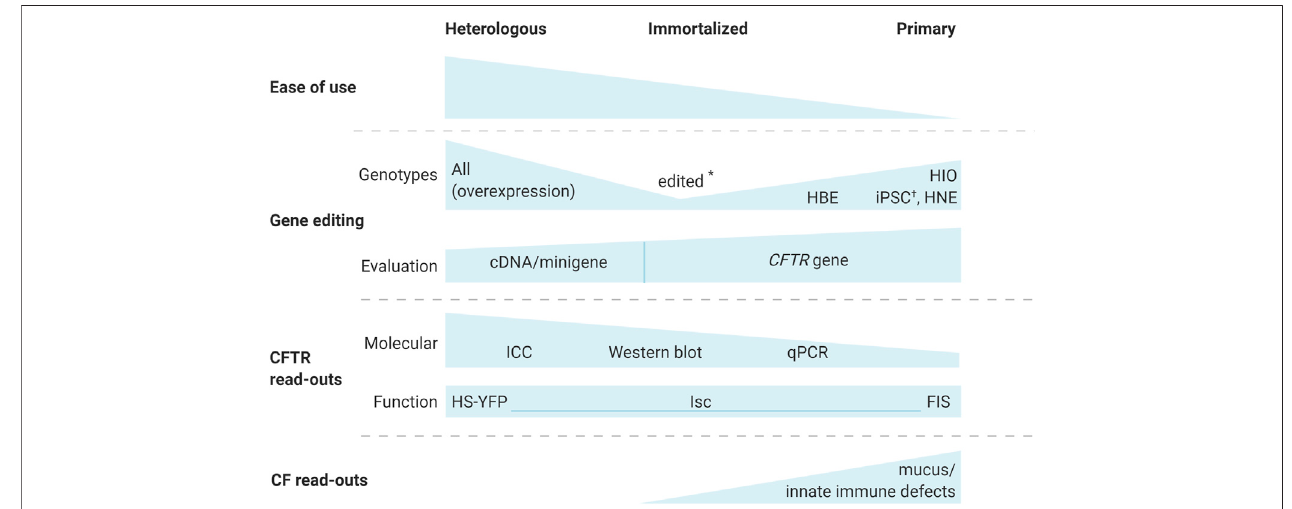
FIGURE 1 | Cystic fi brosis cell models for the evaluation of gene editing strategies. Different cell-based models are available to evaluate gene editing for CF. While heterologous, CFTR overexpressing models allow the study of any CFTR variant, and are easiest to work with, their read-outs are limited to molecular and functional analysisofCFTRandgeneticcorrectionatthecDNAorminigenelevel.Immortalizedcells,expressingtheendogenousCFTR,allowcorrectionofthe CFTR gene,butare only available for a limited number of the more common CFTR genotypes. Gene editing however, has allowed to generate immortalized lines for additional genotypes (*) (Valley et al., 2019). Primary cell models are the most relevant, since they can be used for CF speci fi c read-outs that are important in the CF phenotype, includingmucusandimmunedefects.TraditionalmolecularCFTRendpointsremainchallengingforprimarycells.Dependingontheoriginoftheprimarycells,genotypes mightbeexceedinglyhardtoacquirei.e.,humanbronchialepithelial(HBE)cellsfromexplantlungs.Ontheotherhand,humanintestinalorganoids(HIO)andhumannasal epithelial (HNE) cells are more readily obtained via minimally invasive procedures. Alternatively, iPSCs were edited ( † ) to generate isogenic lines with different genotypes (Ruan et al., 2019). A combination of different models allows the most complete cell-based evaluation of novel gene editing strategies. Abbreviations: FIS, forskolin induced swelling; HBE, human bronchial epithelial; HIO, human intestinal organoids; HNE, human nasal epithelial; ICC, immunocytochemistry; iPSCs, induced pluripotent stem cells; Isc, short circuit currents; HS-YFP, halide sensitive yellow fl uorescent